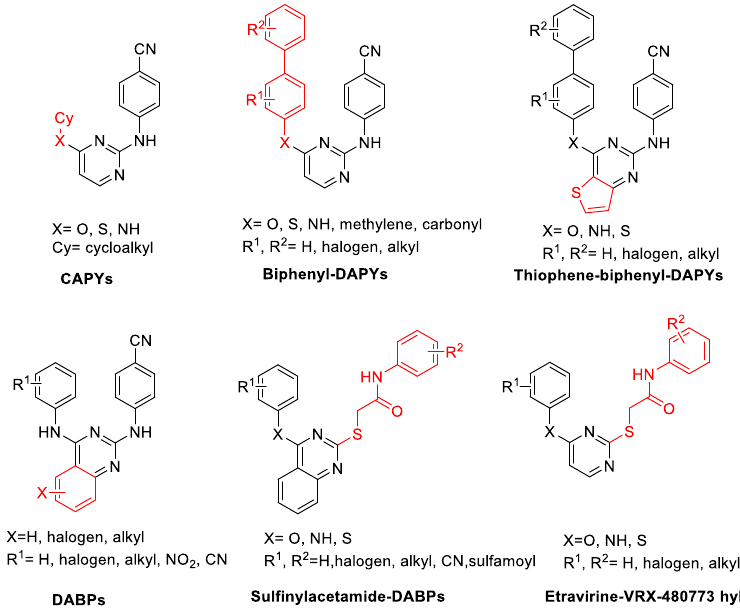
Figure 1. Representative non-nucleoside reverse transcriptase inhibitors (NNRTIs) obtained by the scaffold hopping strategy.